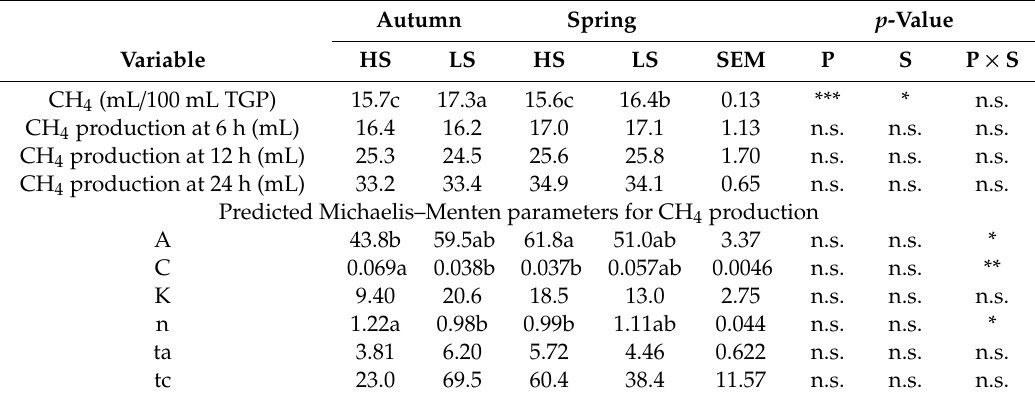
Table 4. E ff ect of pasture type and season on in vitro methane (CH 4 ) output. Autumn